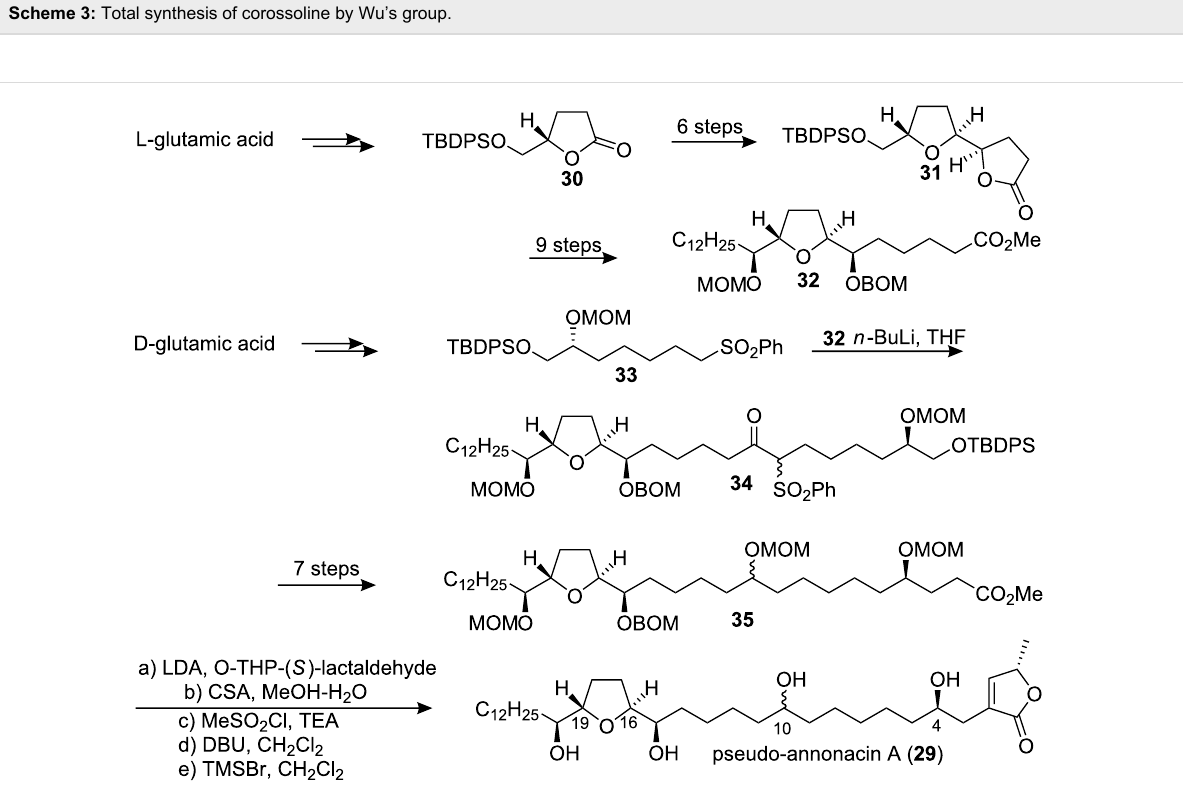
Scheme 4: Total synthesis of pseudo-annonacin A by Hanessian’s